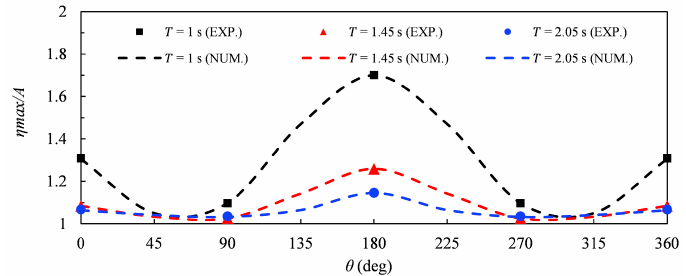
Figure 10. Normalized maximum run-up around the monopile.